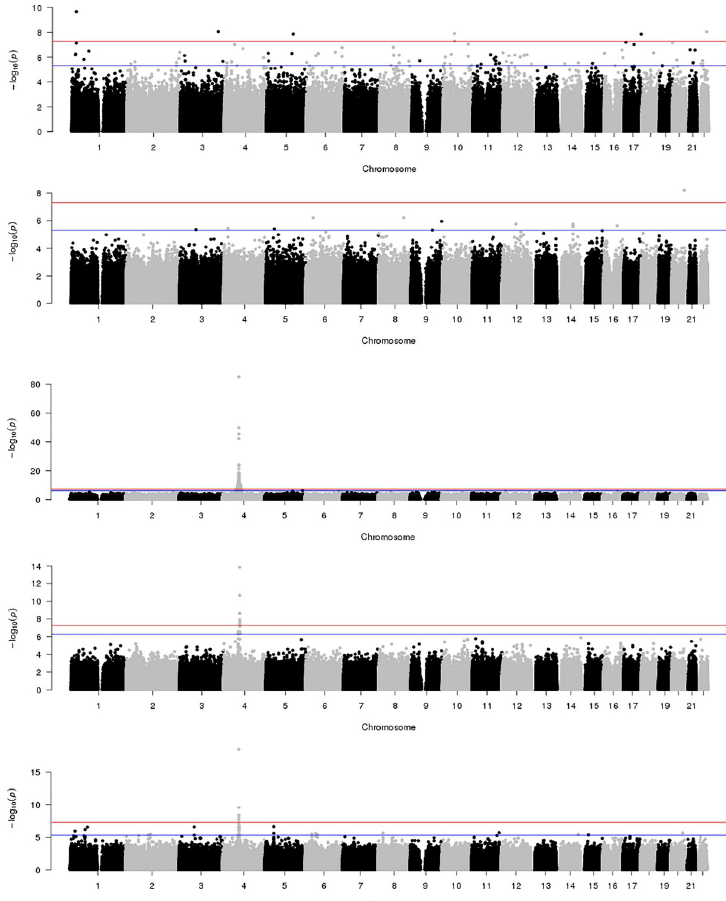
Fig 1. Manhattan plots for trait association results in the African American-Diabetes Heart Study (AA-DHS). A. 25-hydroxyvitamin D, B. 1,25-dihydroxyvitamin D, C. Vitamin D Binding Protein, D. Vitamin D Binding Protein adjusted for rs7041 and E. Bioavailable Vitamin